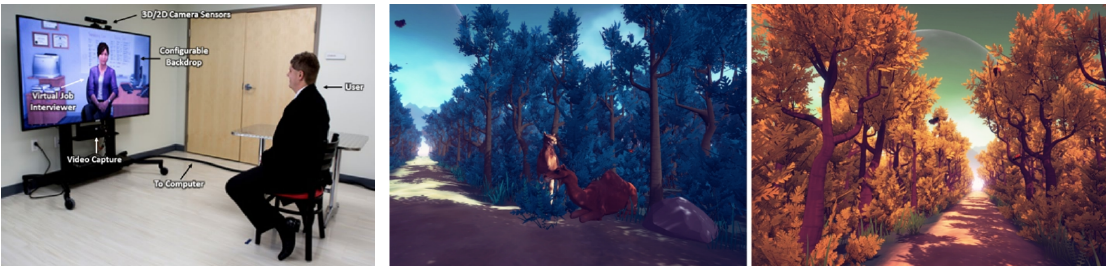
Figure 6. Screenshots of VR applications for special needs education: Left : User interacting with components of VR system [122]. Middle and Right : VR environment that participants moved through while walking on the treadmill